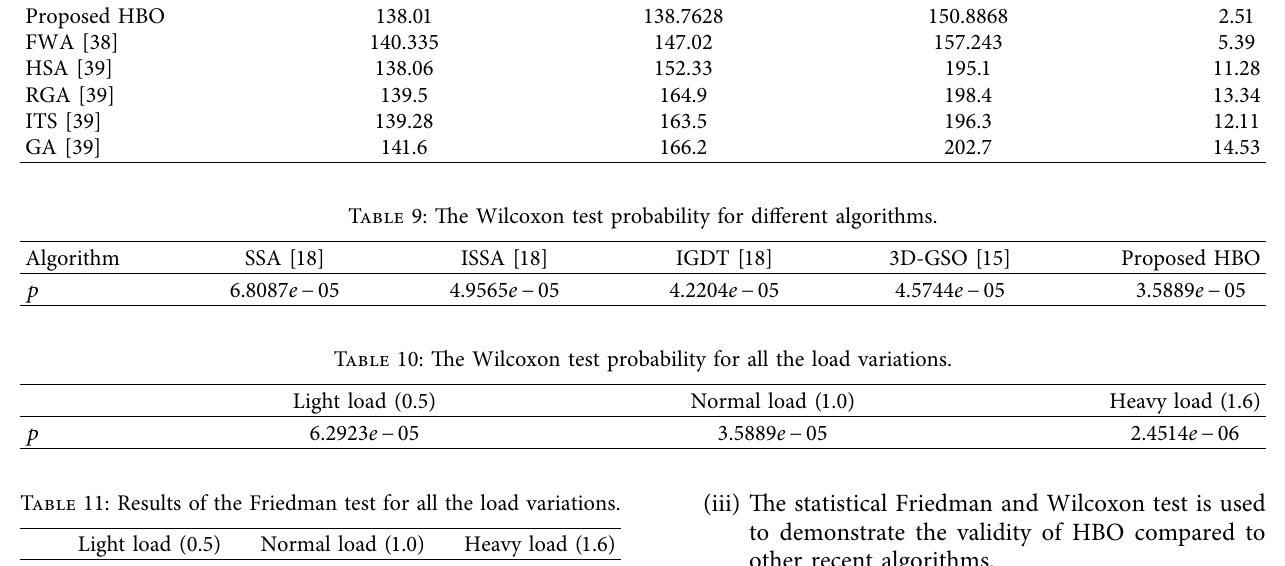
Table 8: Statistical results of only the normal (1.0) case compared to other methods. Method